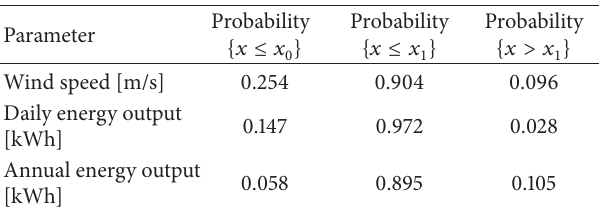
Table 2: Simulation process results.